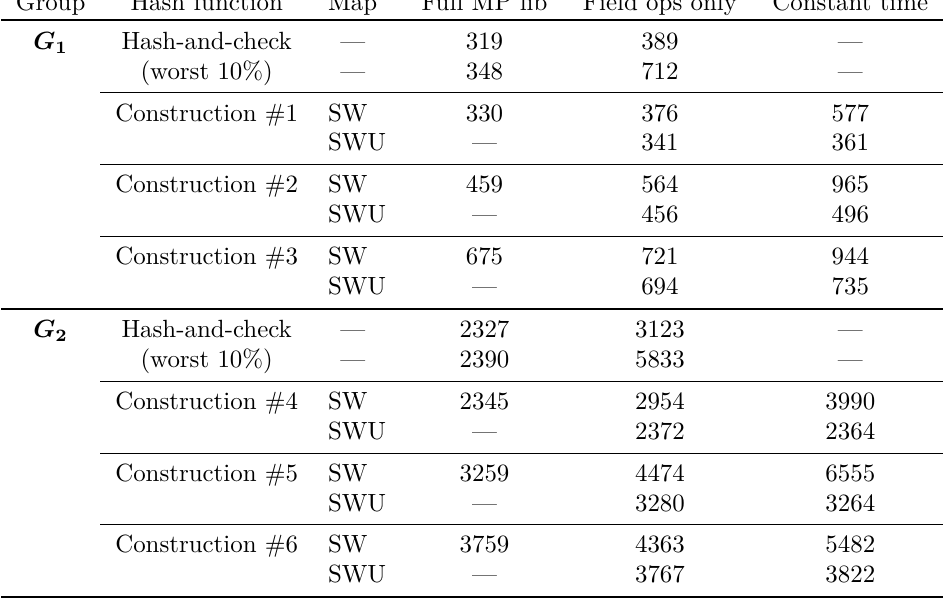
Table 1: Cost in thousands of CPU cycles for hash-and-check and the constructions of Section 5 applied to the maps of Sections 3 (“SW”) and 4 (“SWU”). For hash-and-check, “worst 10%” is the mean of the slowest 10% of runtimes. “Full MP lib” implementations use complex functionality from GMP (§6), “Field ops only” implementations are restricted to field operations, and “Constant time” implementations are further restricted to executing in time independent of the value (but not the length) of the hash